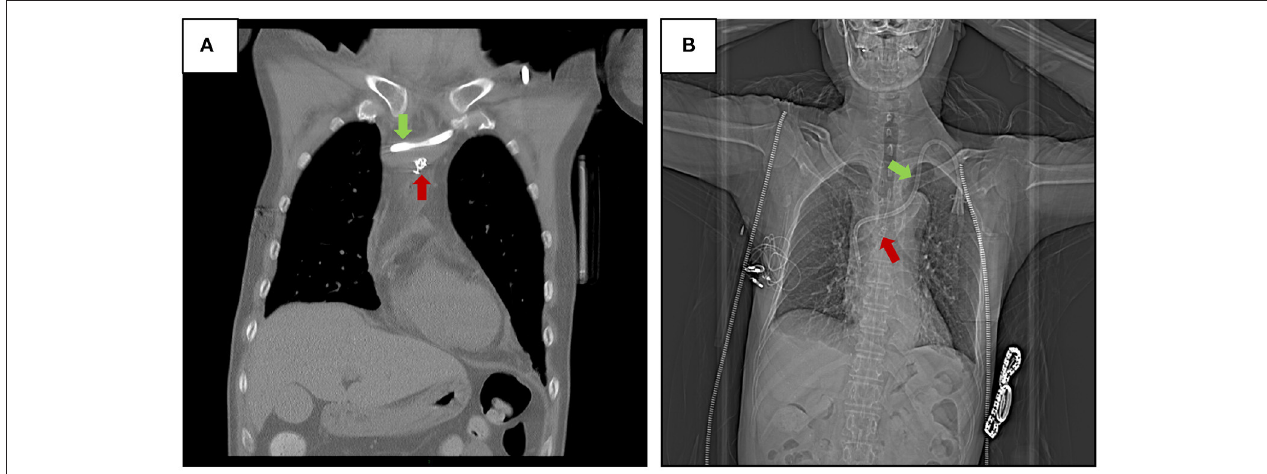
FIGURE 3 | Two embolization microcoils (COOK d ≈ 5mm) were inserted to block the vascular rupture (A) , and X-ray revealed that the cuff catheter and embolization microcoil were appropriately located in the brachiocephalic vein (B)